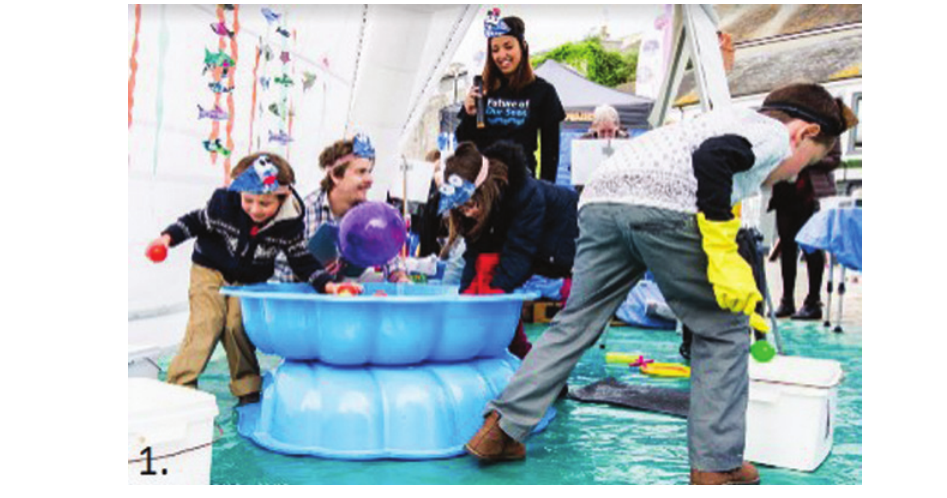
figure 1: Visual example of having a two-way conversation during the ‘Mighty louis the Mussel’ game activity (see activity 1, below) (photograph: Ben